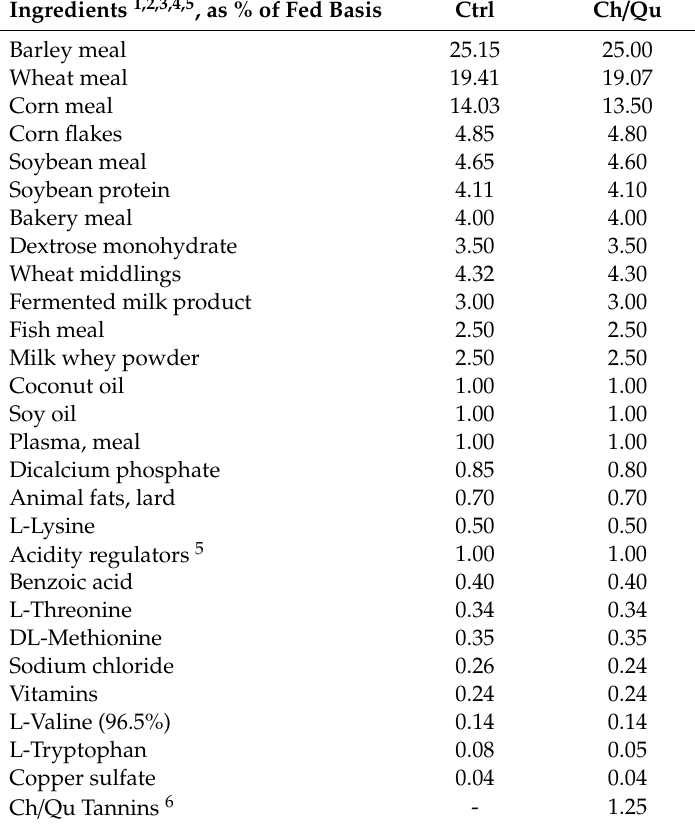
Table 1. Ingredient composition of the experimental diets administered to weaned piglets (control (Ctrl), n = 60; chestnut / quebracho (Ch / Qu), n = 60) from day 0 to day 40 of the experimental trial on an as-fed